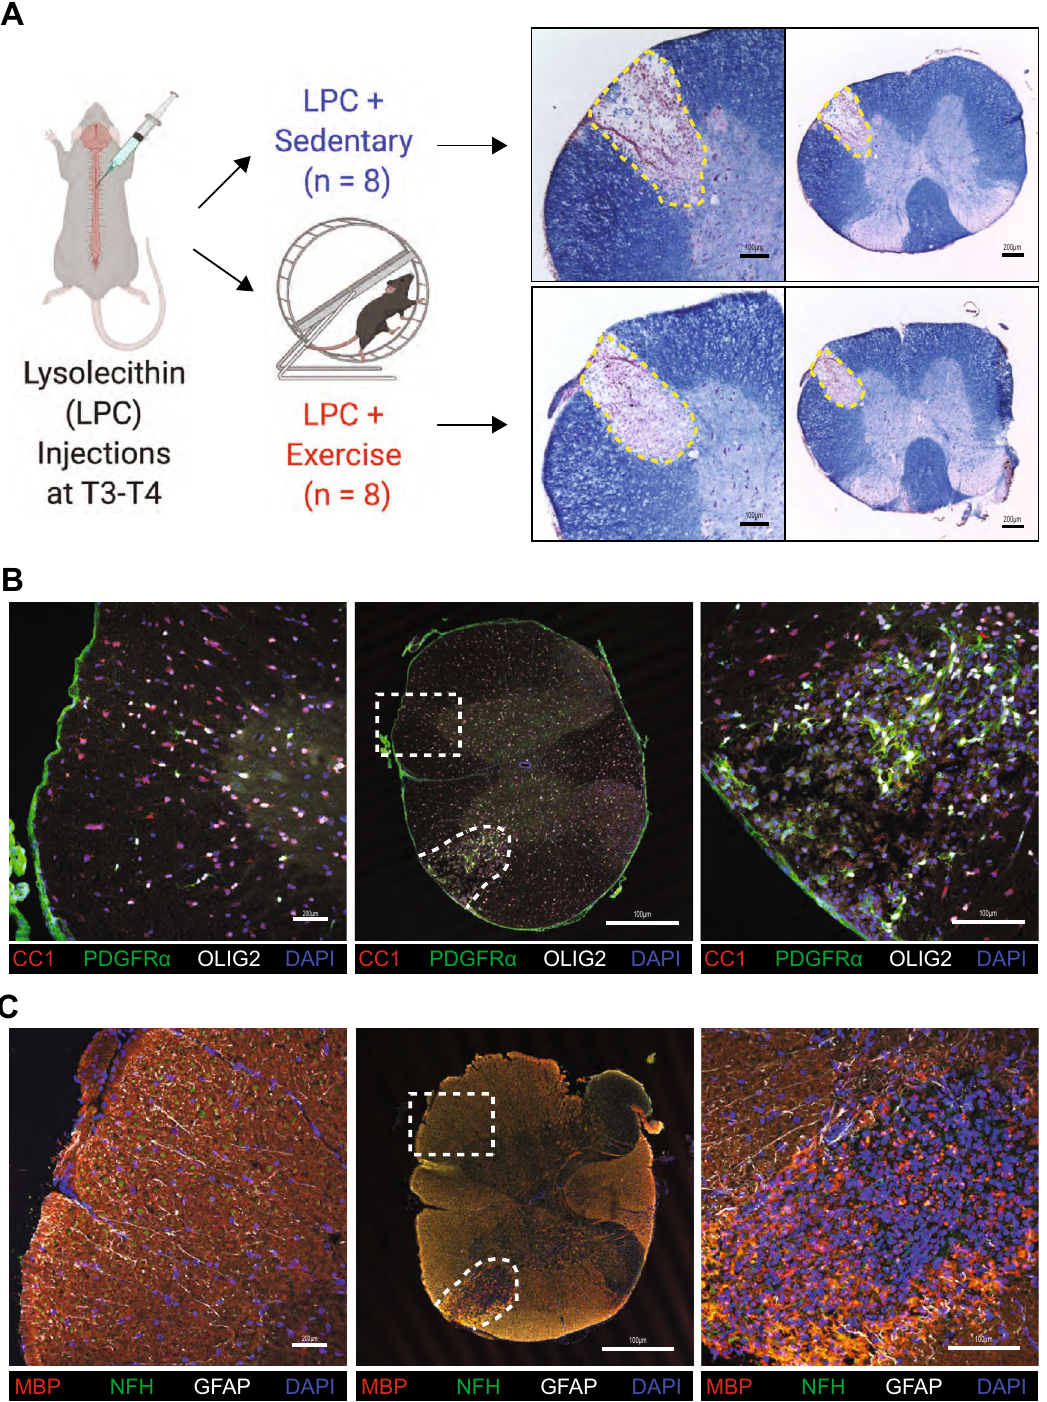
Figure 3. Impact of LPC surgery on mice subjected to running wheel. ( A ) Workflow and representative eriochrome cyanine-stained sections with lesion in the ventrolateral white matter delineated by dashed lines. Figure was drawn using BioRender. ( B ) Representative images of LPC lesion (left) and contralateral normal appearing white matter (right) 4 days post injury stained for mature oligodendrocytes (CC1) in red, OPCs (PDGFRα) in green, oligodendrocyte lineage cells (OLIG2) in white, and DNA (DAPI) in blue. ( C ) Representative images of LPC lesion 4 days post injury stained for myelin and myelin debris (MBP) in red, axons (NFH) in green, and astrocytes (GFAP) in white, and DNA (DAPI) in blue. In both ( B ) and ( C ), the lesion is outlined by the irregular dashed line while the non-involved contralateral site is denoted by the rectangle dashed line. Scale bar represents 100